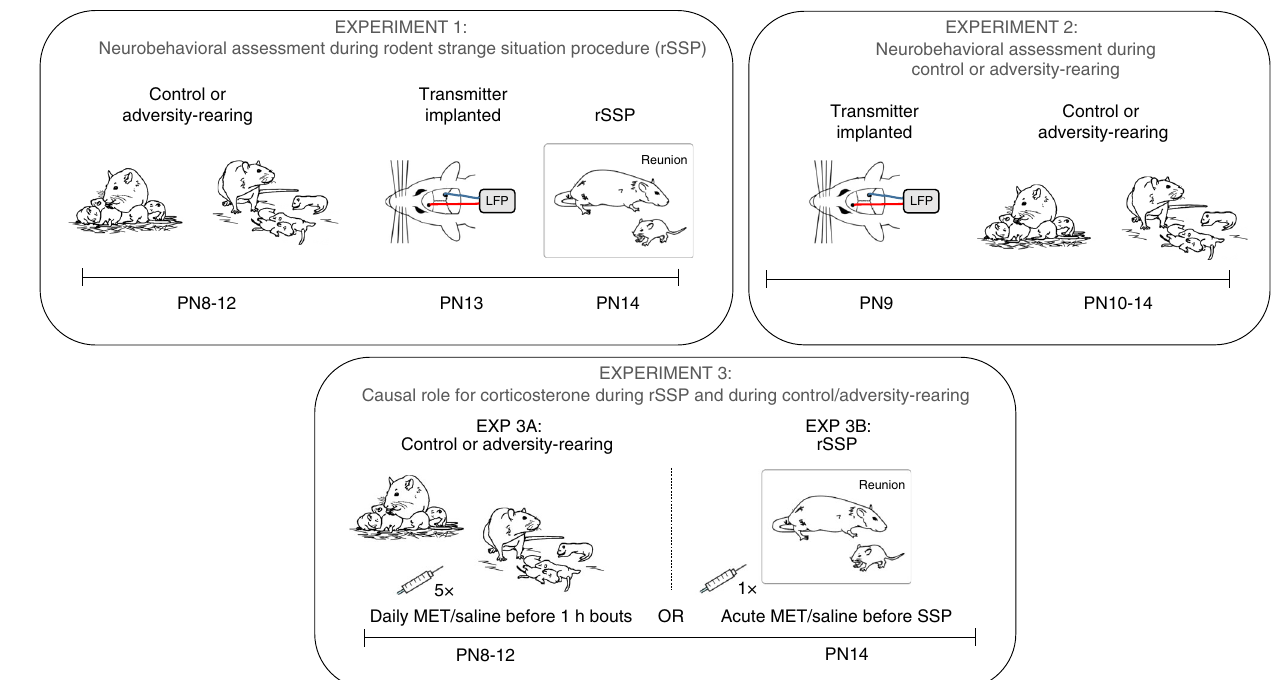
Fig. 1 Rodent experimental design. In all rodent experiments, we used the scarcity-adversity model of low bedding, which induced maltreatment of pups in the rat mothers. In Experiment 1, adversity-rearing occurred from PN8 – 12 and at PN13 – 14, pups were removed from the nest and given the rodent rSSP while cortical LFP was recorded. In Experiment 2, neurobehavioral assessment of pups occurred during the control or adversity-rearing. Experiment 3 assessed causation in Experiment 1 and Experiment 2 results by blocking corticosterone synthesis. All pups experienced control or adversity-rearing from PN8-12, and then one cohort of pups received daily injections of metyrapone or saline 90 min before bedding was removed (5 administrations total, EXP